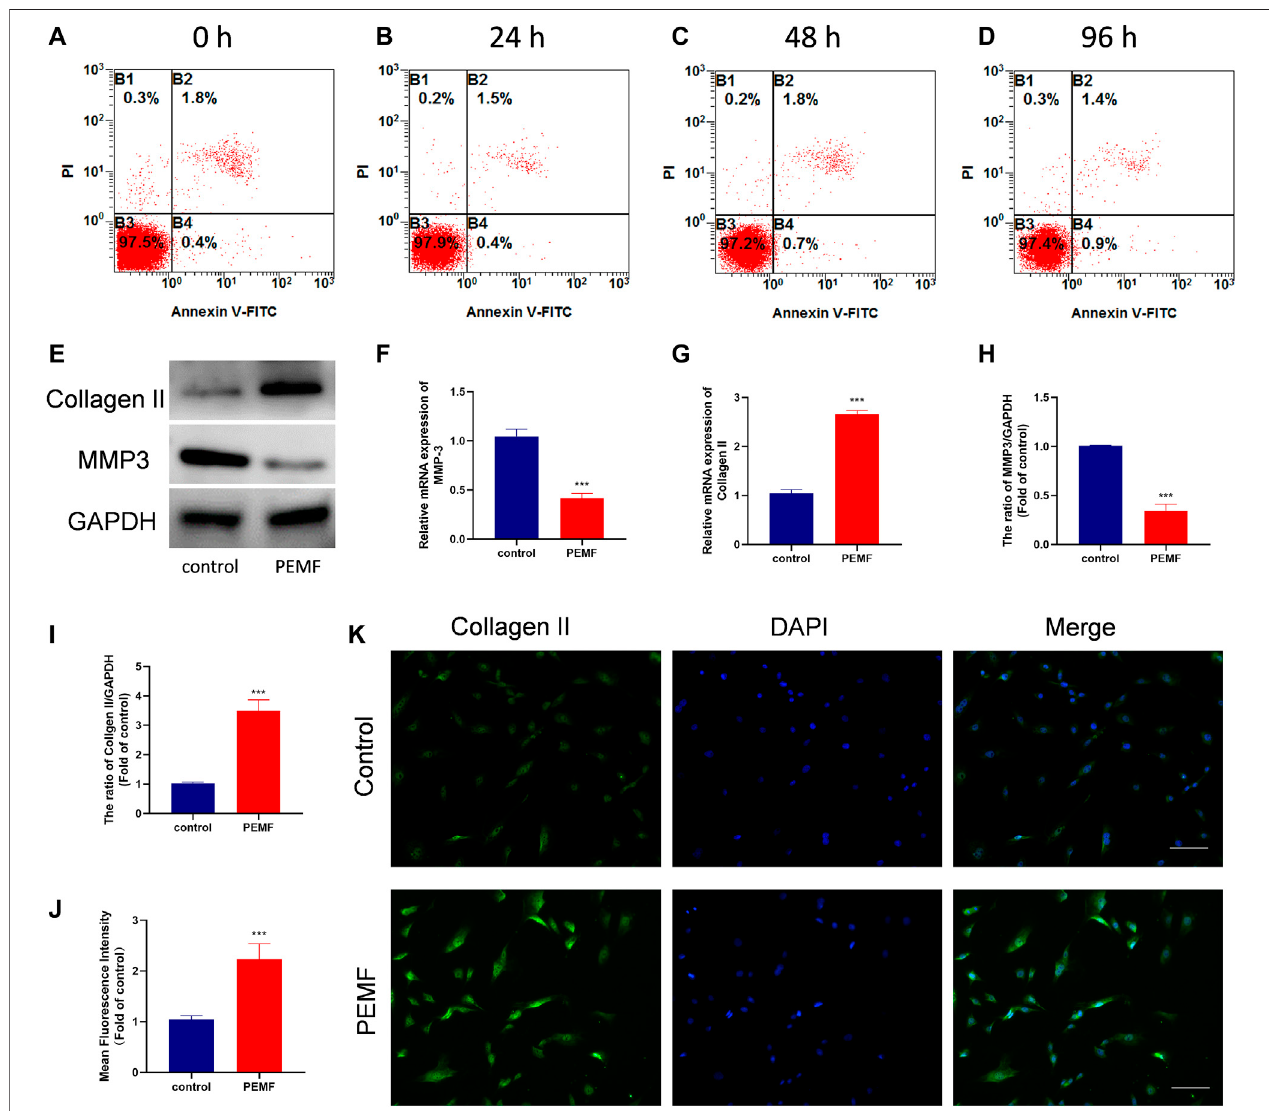
FIGURE2| PEMF attenuates cell degenerationin human degenerated NPcells. (A – D) The apoptosis ratioofNP cellsat time points 24, 48,and 96 hafter 4 h/day ofPEMFadministration. (E – I) TheqRT-PCRanalysisofCollagenIIandMMP-3transcripts(n=3),westernblotandsemi-quantitativeanalyses ofCollagenIIandMMP-3 protein levels (n = 3). (J – K) Representative images of immuno fl uorescence and semi-quantitative analyses of Collagen II fl uorescence intensity in NP cells, imaged by fl uorescence microscopy (scale bar = 50 μ m). *** p < 0.001. Data presented as means ± SD.